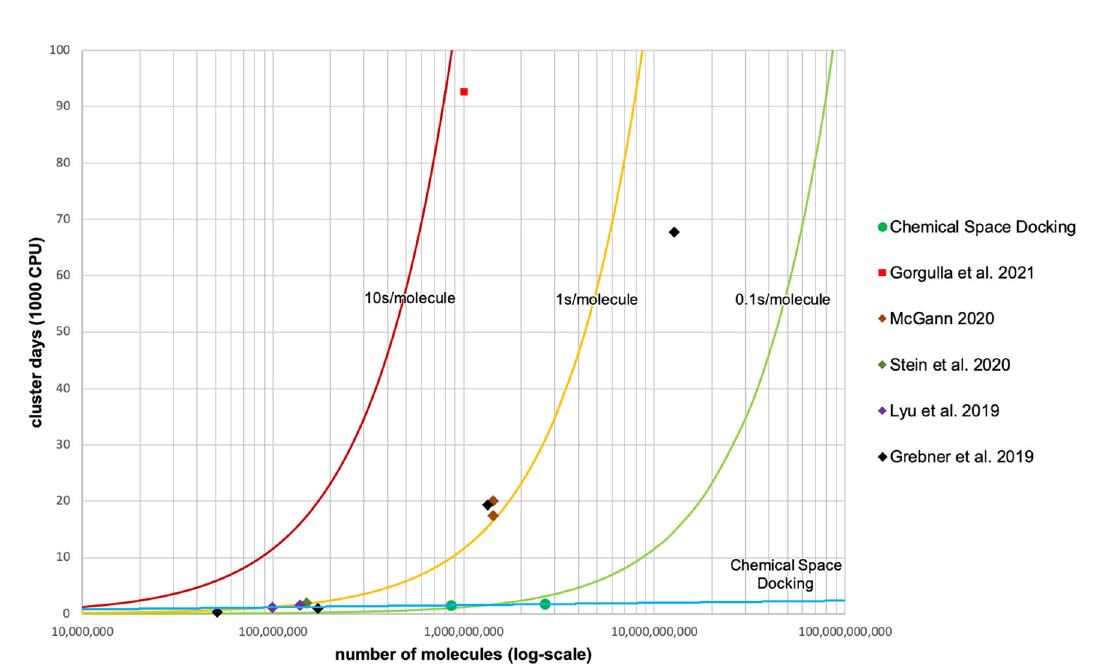
Fig. 6 | Computational requirements for large-scale docking campaigns. Tra- ditional full enumeration docking curves are calculated based on the time needed to dock each molecule: 10s (red), 1s (yellow), 0.1s (green). Chemical Space